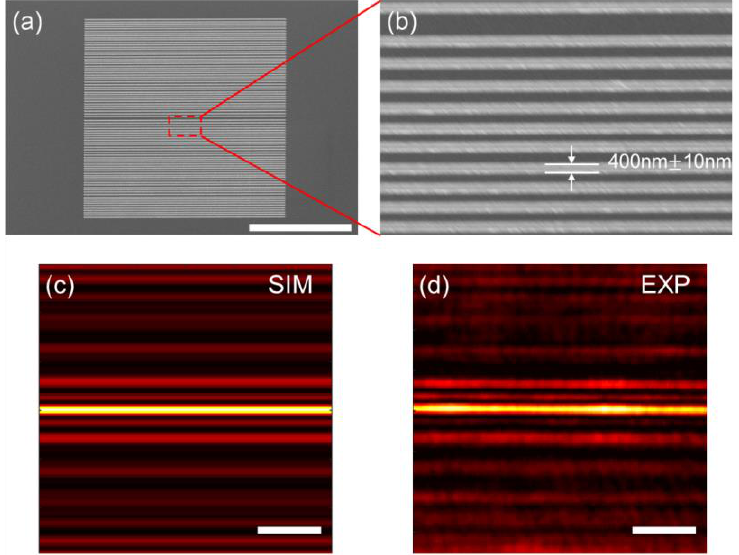
Figure A3. ( a , b ) The SEM image and its sectional zoom-in view of the grating-type cylindrical supercritical lens, scalebar: 50 µ m; ( c , d ) the field intensity distribution in the XOY plane of the transverse optical needle created by the grating-type cylindrical SCL for the simulated result ( c ) and the experimental result ( d ), scalebar: 3 µ m.